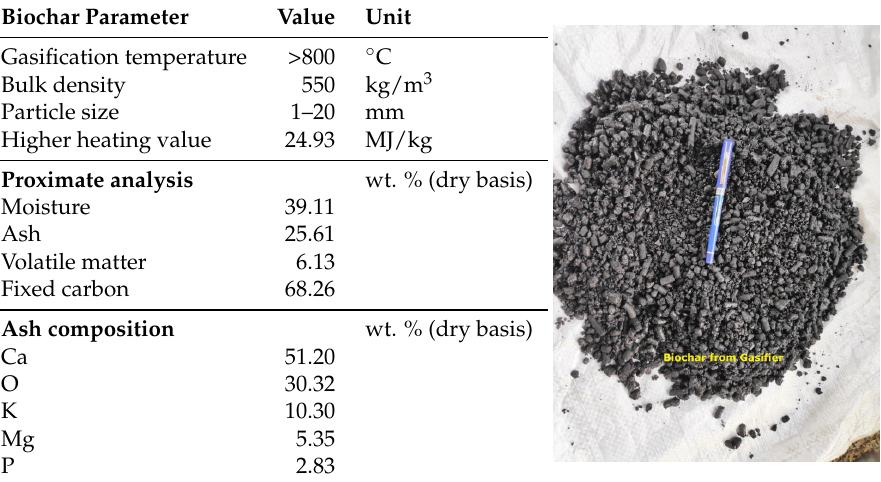
Table 9. Physicochemical properties and sample of biochar from exhausted olive pomace